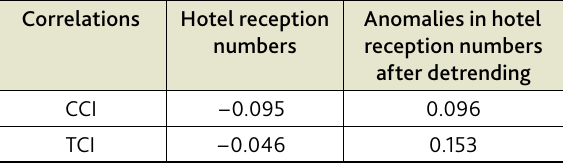
Table 6. Correlation coefficients for the CCI and TCI, hotel reception numbers, and anomalies of hotel reception numbers (after detrending) on Hainan. Correlations Hotel reception Anomalies in hotel